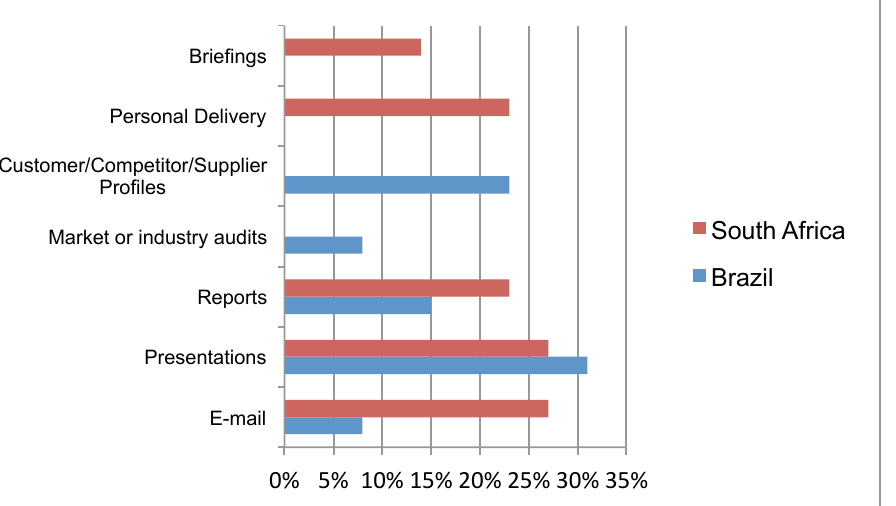
Figure 5: Methods used to distribute & present CI